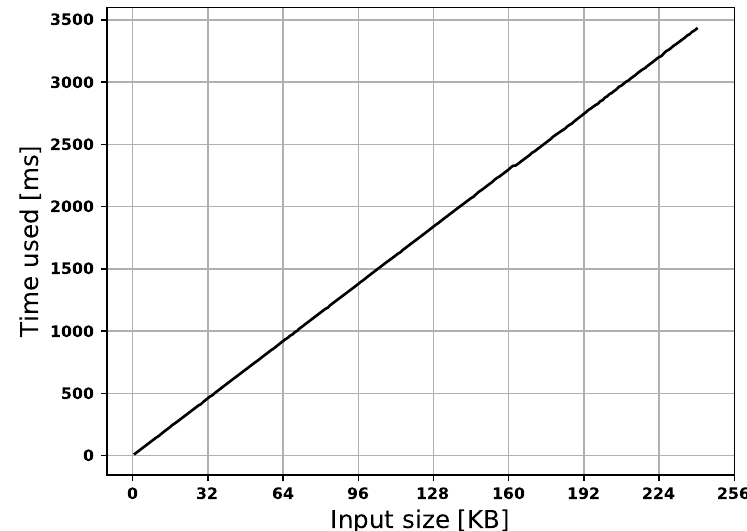
Figure 15. Time used to transmit memory.